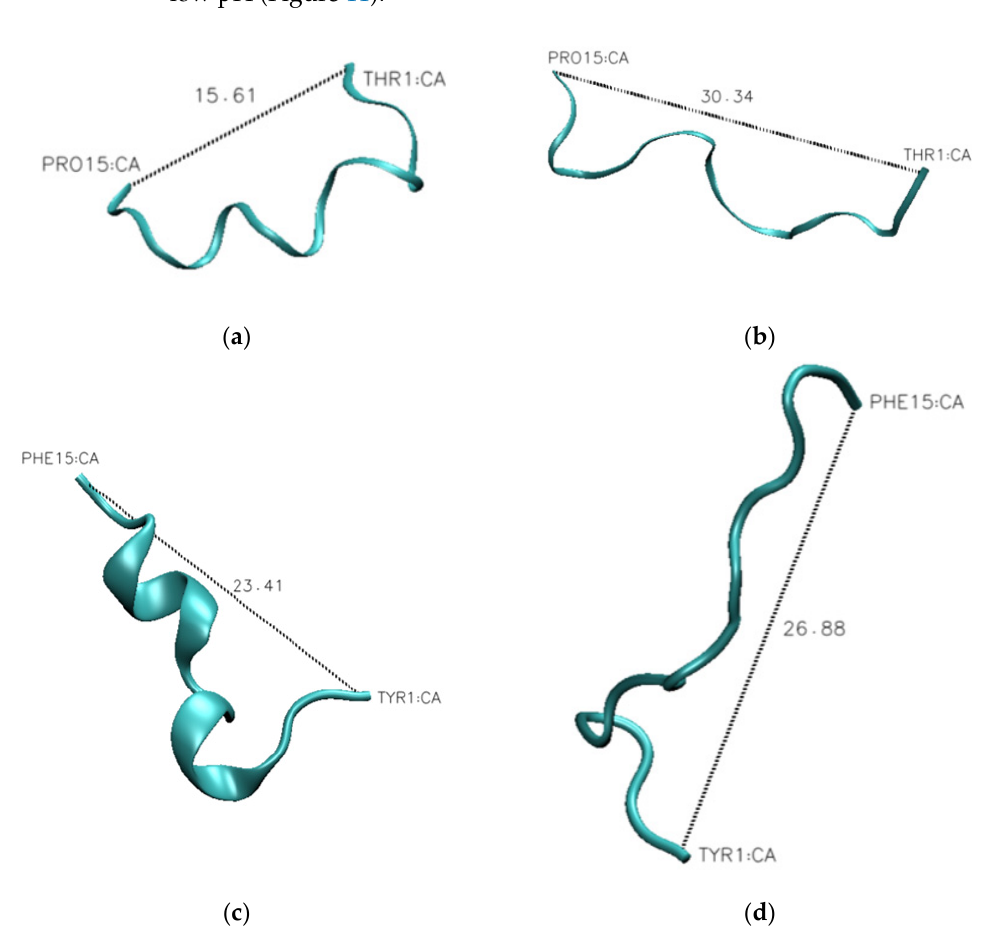
Figure 10. Representative structures of the wild-type peptide (P1) and the aromatic peptide (P3) show an increased secondary structure in P3. Representative structures of the P1 peptide at pH 1 ( a ) and pH 12 ( b ) demonstrate that the P1 peptide has a more extended conformation at pH 12. Representative structures of the P3 peptide at pH 1 ( c ) and pH 12 ( d ) demonstrate that the P3 has a significant secondary structure at pH 1. The distance between the initial and final α -carbons are reported in ångströms.